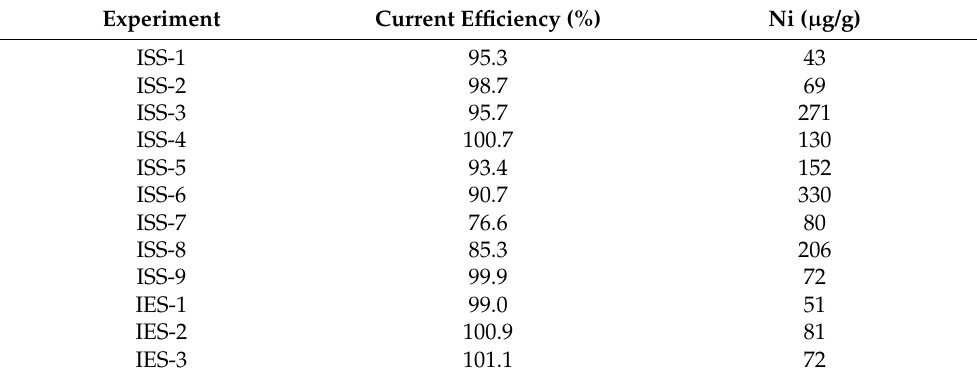
Table 9. Summary of the electrolyte inclusion experiments. Ni concentration in the solid cathode, based on total dissolution to aqua regia and analysis by